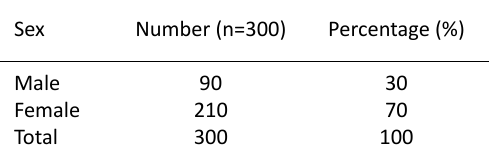
Table 1. Sex distribution among the health care workers who were sampled.